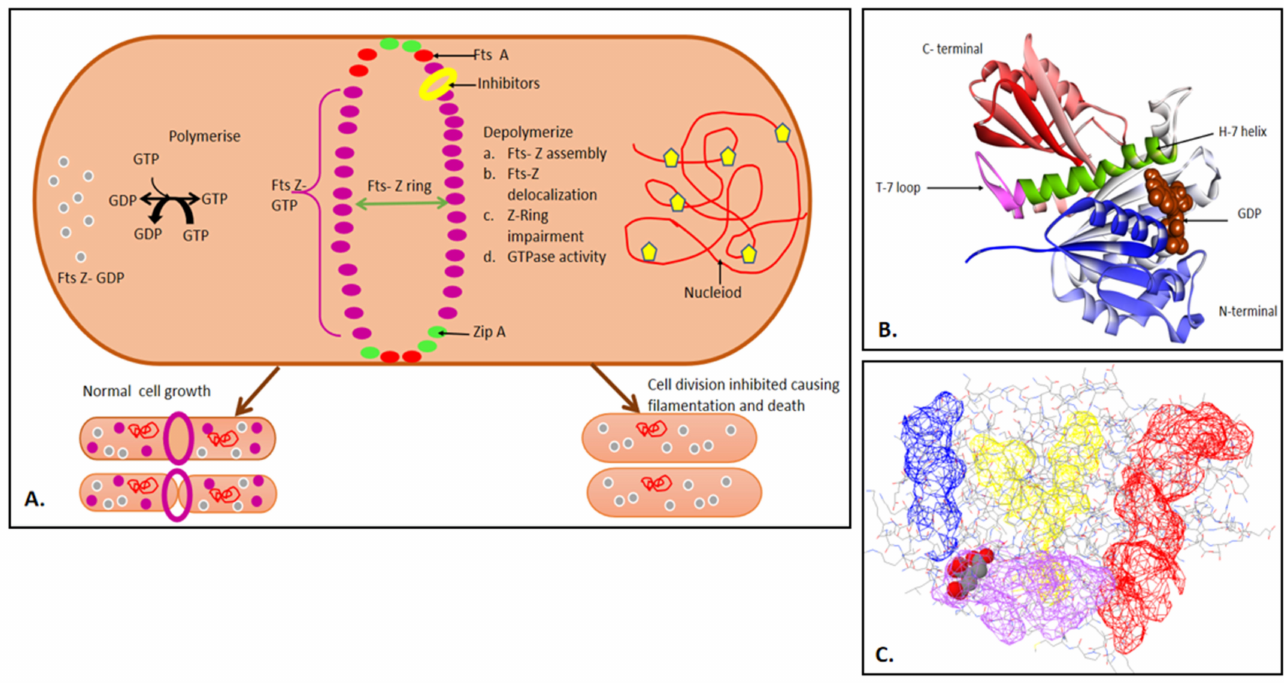
Figure 1. ( A ) An illustration representing the role of Fts-Z in the Z-ring assembly pathway, empha- sizing normal and interrupted cell division in bacteria; ( B ) Structure of Fts-Z protein from S. aureus (PDB ID-2VXY) in ribbons bound to GDP (in brown CPK). The T7 loop is in pink and α -H7 helix is in green. The blue-colored portion is the N-terminal and the green portion is the C-terminal. The figure was visualized in BIOVIA Discovery studio visualizer v21.1; ( C ) The binding sites present on the Fts-Z protein. (Figure generated through PDBSUM)